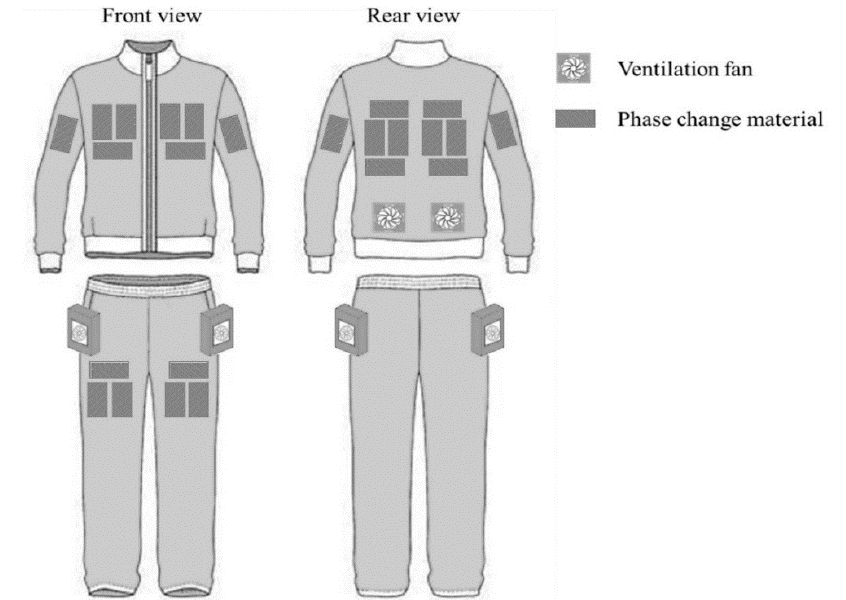
Figure 1. Schematic chart of the new HPCS.